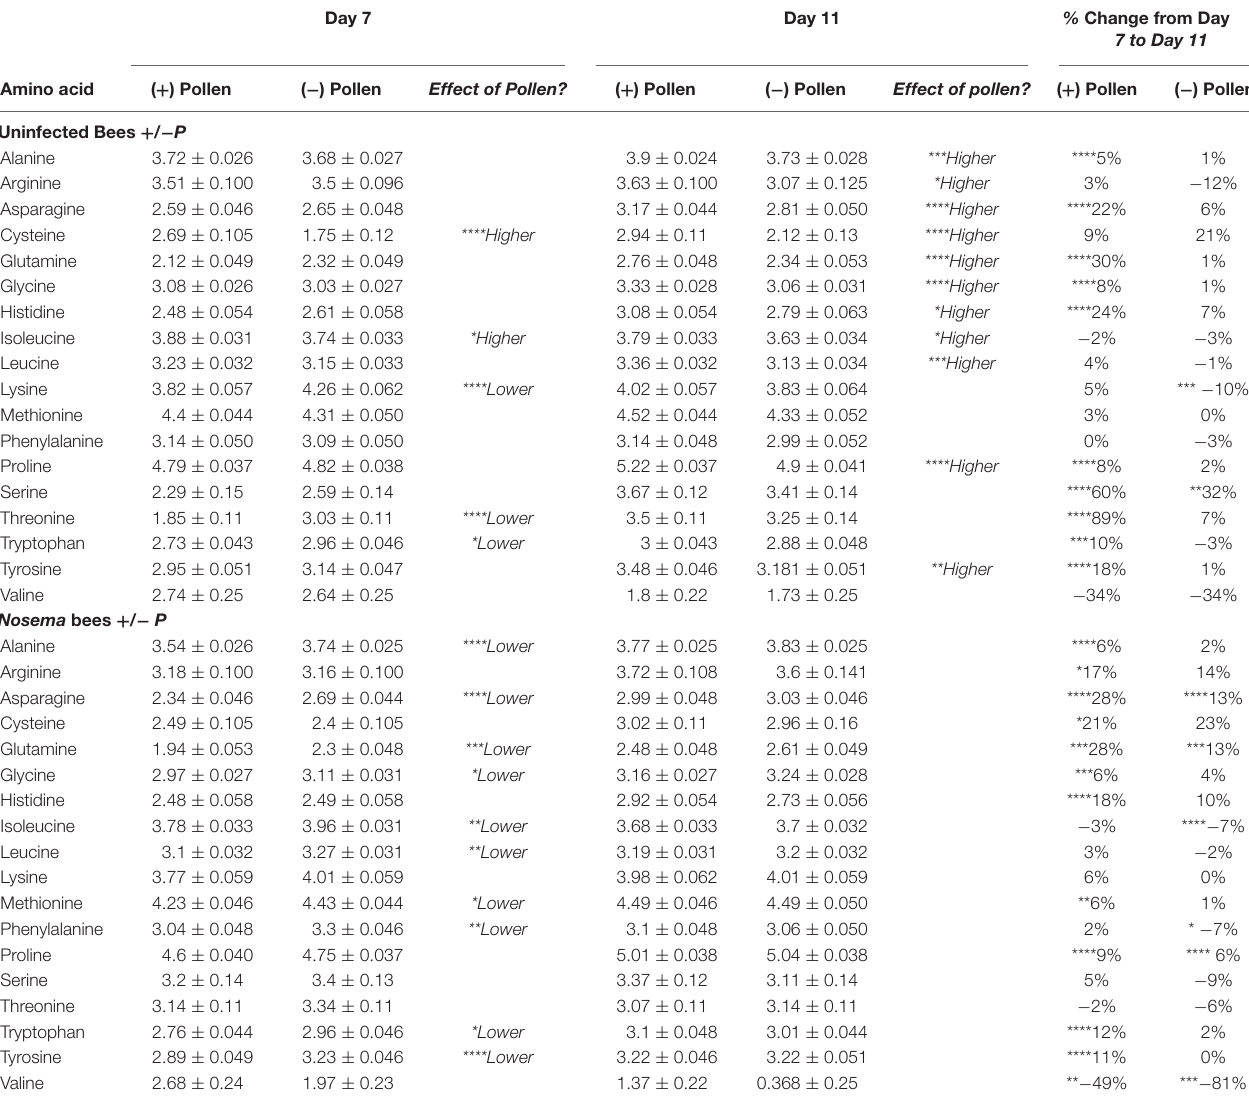
TABLE 1 | Brain levels of amino acids in response to pollen, age and Nosema ceranae infection. Day 7 Day 11 % Change from Day